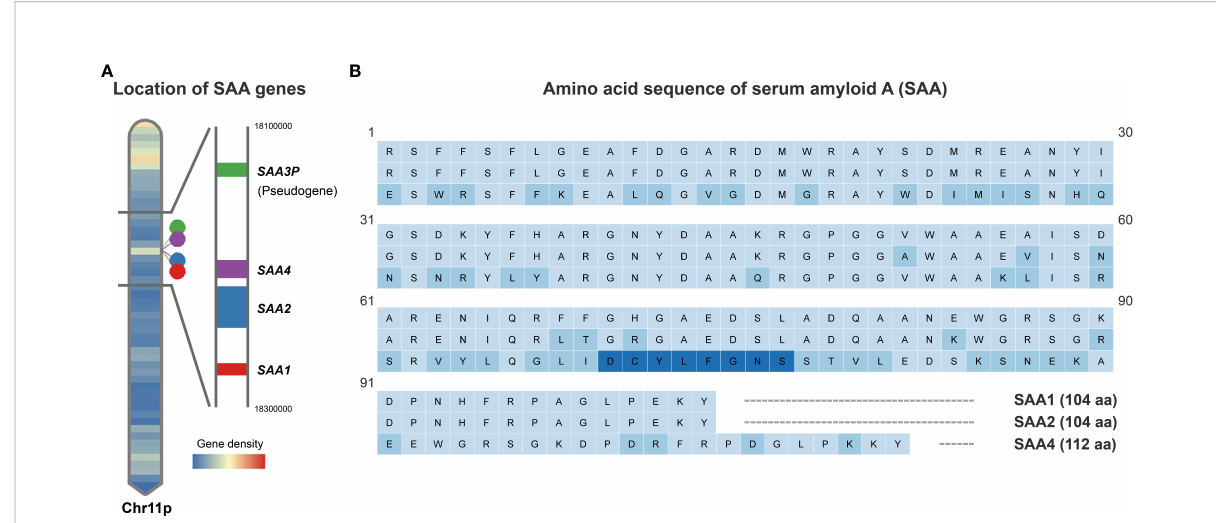
FIGURE 1 Schematic depiction of human SAA gene locations and protein sequences. (A) . Human SAA genes including SAA1 , SAA2 , SAA4 and pseudogene SAA3P clustered in a 150-kb region on the short arm of chromosome 11. (B) . Comparison of the amino acid sequences encoded by the human SAA1 , SAA2 and SAA4 genes based on UniProt Knowledgebase entries P0DJI8, P0DJI9 and P35542. Amino acid residue variations compared to SAA1 are marked in light blue and an additional 8 amino acids inserted between amino acid residues 69 and 70 of the SAA1/2 in SAA4 are marked in dark